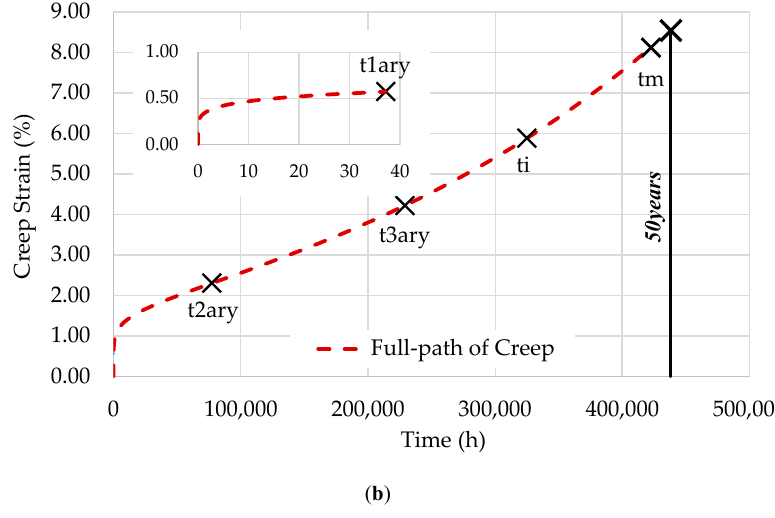
Figure 4. T28-S35: ( a ) data fitting; ( b ) full path of creep and transition points. Based on D 0 , the compliance in the glassy state is given by D 0 = k / σ . Table 3 summarizes the values of 𝐷 (cid:2868) and the parameters used to obtain the creep compliance for each stress level. Table 3. Parameters to obtain the creep compliance by EPL expression. Specimen Stress